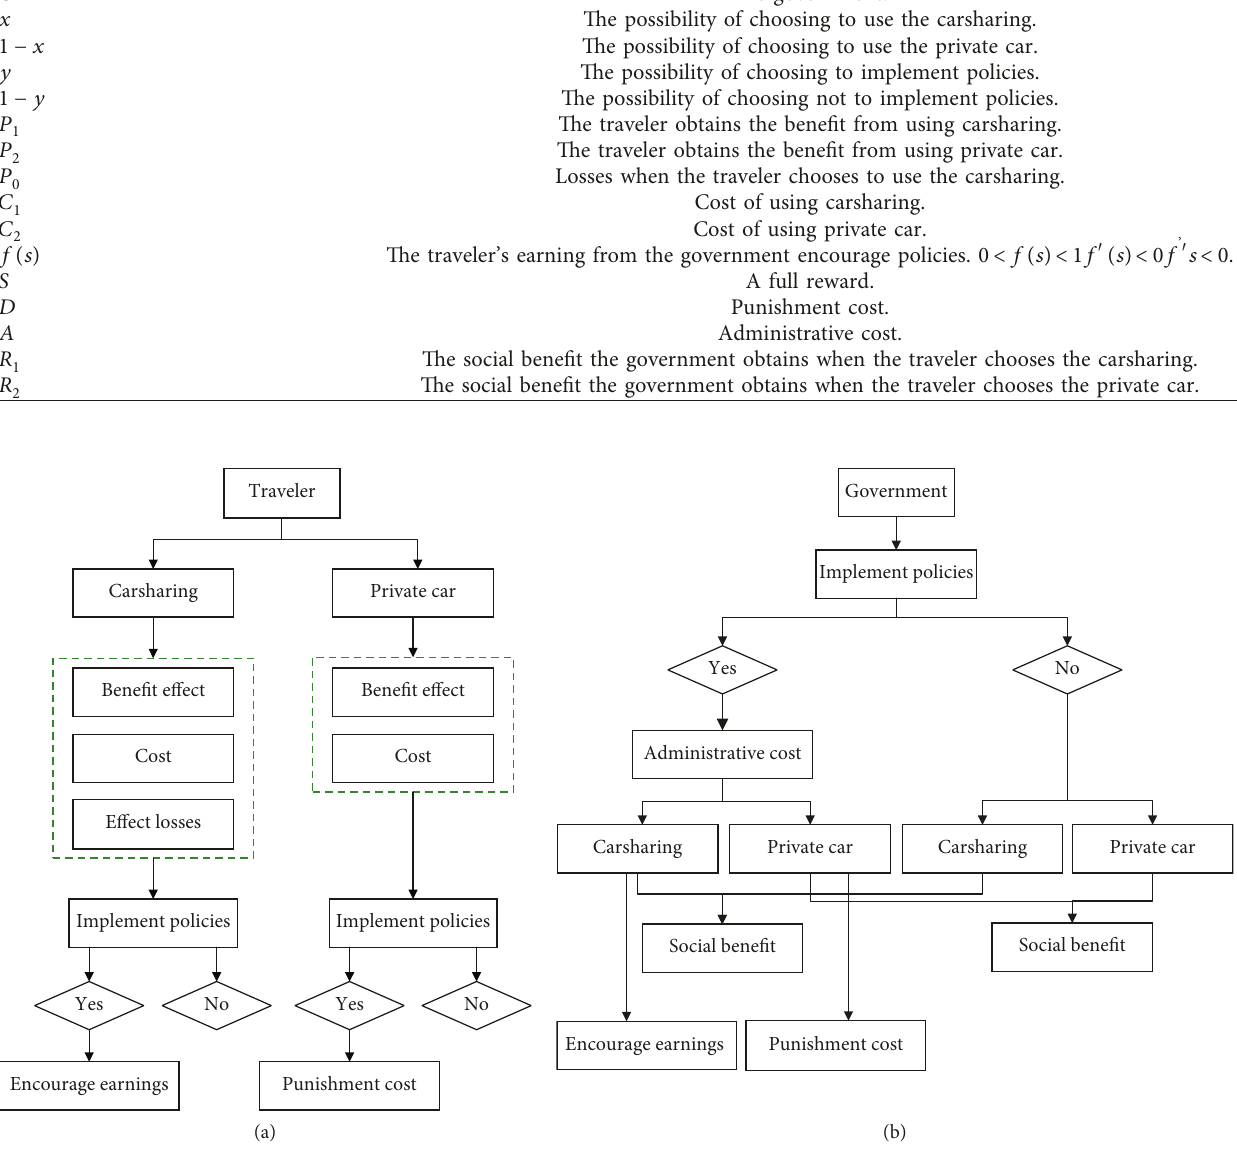
Figure 3: The different choice processes of the traveler and government: (a) traveler and (b) Table 2: Payoff bimatrix of the traveler and the government.